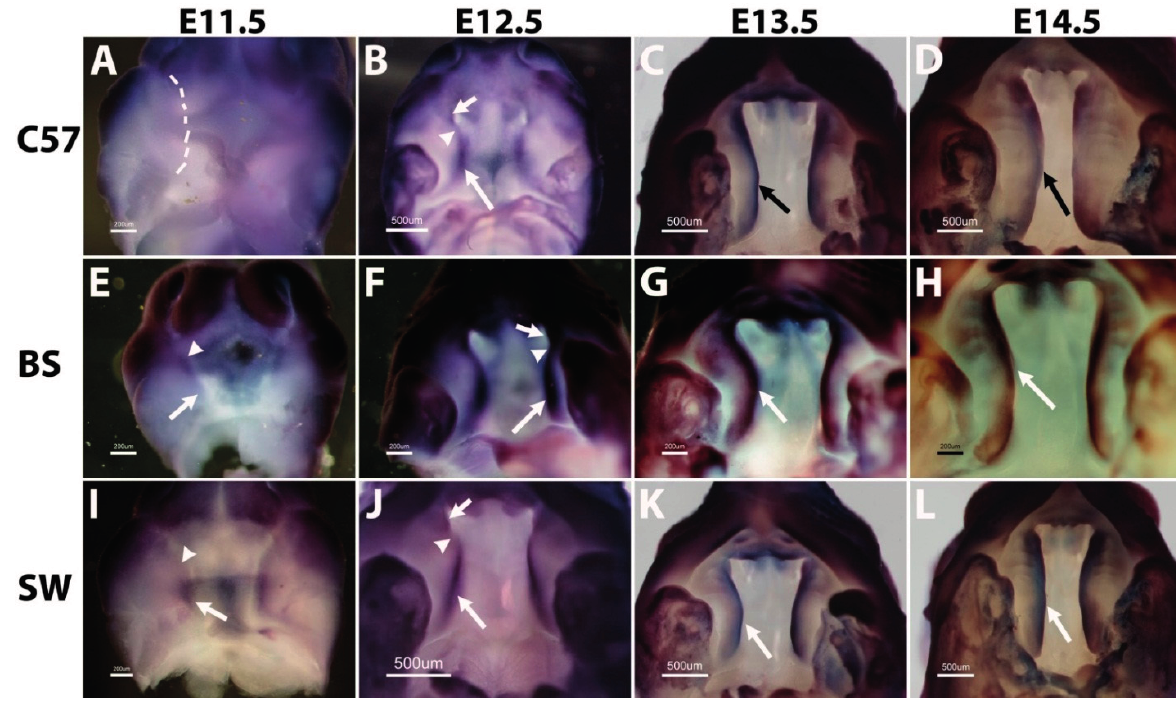
Figure 2. Fgfr1 gene displays divergent expression patterns during mouse secondary palate formation among C57B6 ( A – D ), Black Swiss ( E – H ) and Swiss Webster ( I – L ) strains. The dashed line in ( A ) indicates the unstained palate outgrowth. Scale bars represent 200 µm ( A , E and I ) and 500 µm ( B – D , F – H and J – L ); arrows and arrowheads indicate different